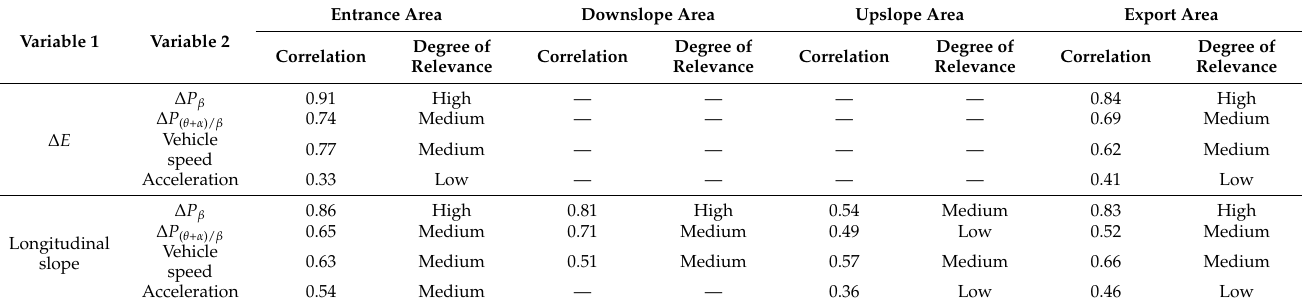
Table 1. Correlation analysis